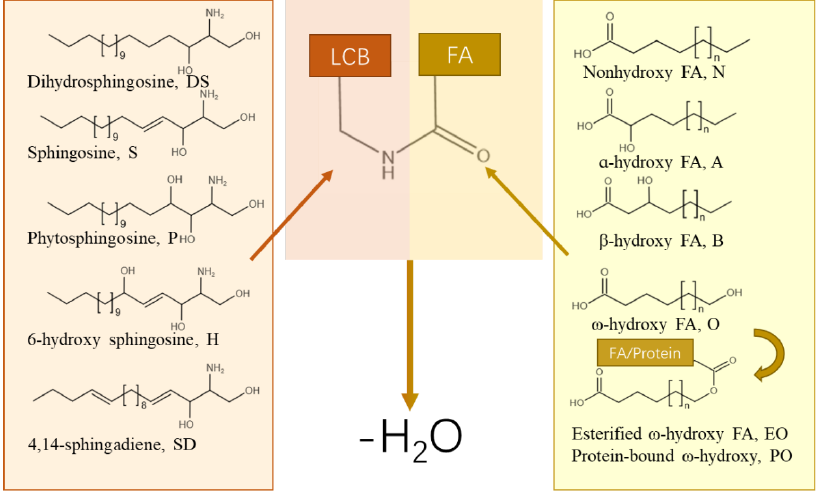
Figure 1. Structures and nomenclature for Cer classes in